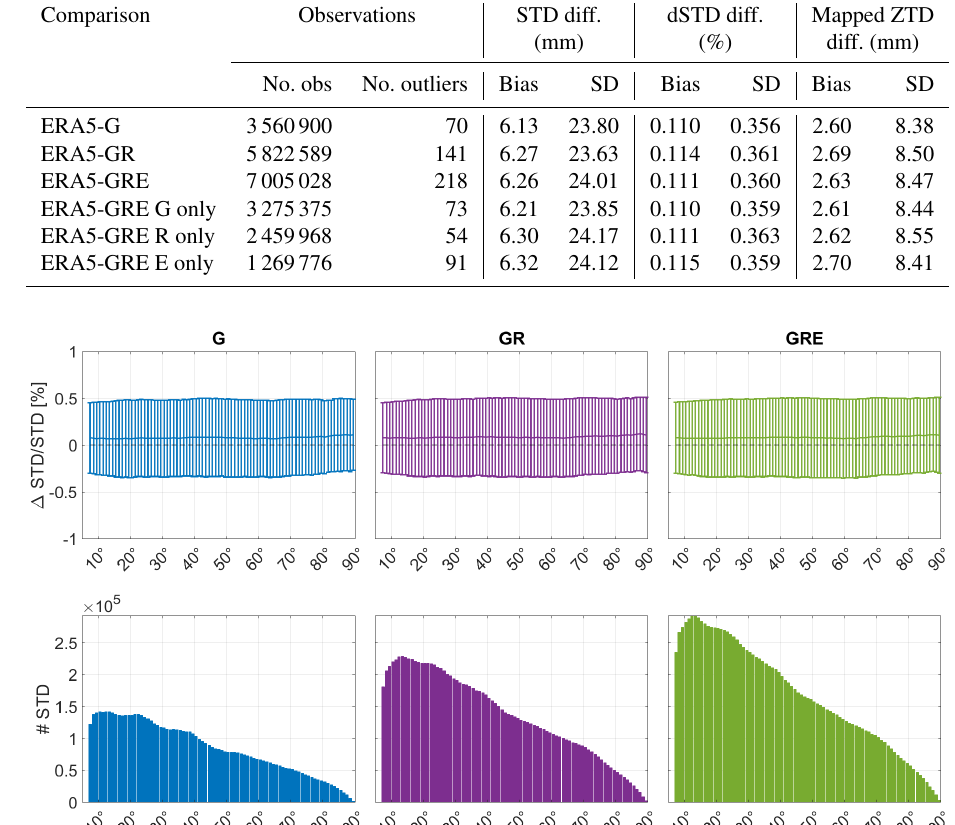
Figure 15. The STD relative differences between ERA5 and the three different GNSS solutions: GPS-only, GR and GRE (top panels) and the number of observations with respect to the elevation angle for each solution (bottom). The differences are calculated for the entire year of